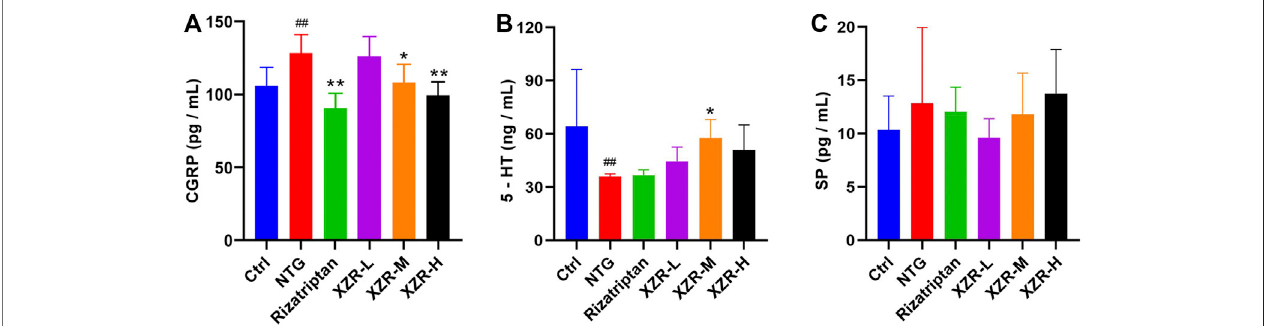
FIGURE 3 | XZR regulated neuropeptide and neurotransmitter levels in rats with NTG-induced migraine. (A) CGRP in serum, n = 6, (B) 5-HT in plasma, n = 6, and (C) SP in serum, n = 5. Data are presented as the mean ± standard deviation. ## p < 0.01 versus the control group, * p < 0.05, ** p < 0.01 versus the NTG group. XZR, Xiongshao Zhitong Recipe; CGRP, calcitonin gene-related peptide; 5-HT, 5-hydroxytryptamine; SP, substance P; NTG, nitroglycerin.